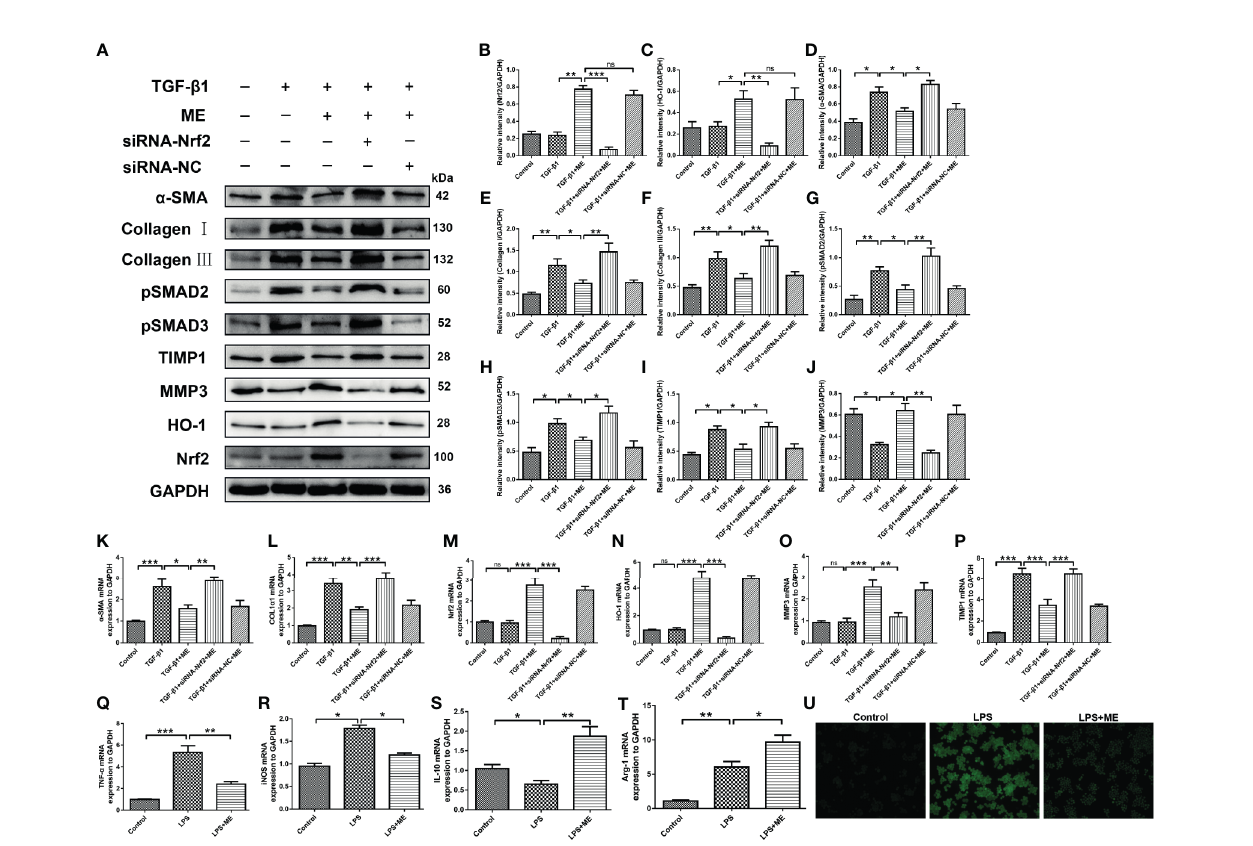
FIGURE 6 | ME inhibits TGF- b 1-induced differentiation of CCD-18Co cells via upregulating Nrf2 expression. (A) Cells were treated with a combination of TGF- b 1, ME, siRNA-Nrf2 or siRNA-NC, and the protein levels of Nrf2, HO-1, a -SMA, Collagen I, Collagen III, pSMAD2, pSMAD3, TIMP1 and MMP3 were detected and normalized to GAPDH. Representative data are demonstrated. (B – J) Western blot bands displayed in (A) were evaluated using densitometry. (K – P) mRNA expression levels of the fi brosis markers were detected and normalized to GAPDH. (Q – T) mRNA expression levels of macrophage markers were detected and normalized to GAPDH. (U) RAW 264.7 cells were stimulated with LPS. Green fl uorescence represented the generated ROS. Data are presented as mean ± SD. ∗ P < 0.05, ∗∗ P < 0.01, and ∗∗∗ P < 0.001; ns, no signi fi